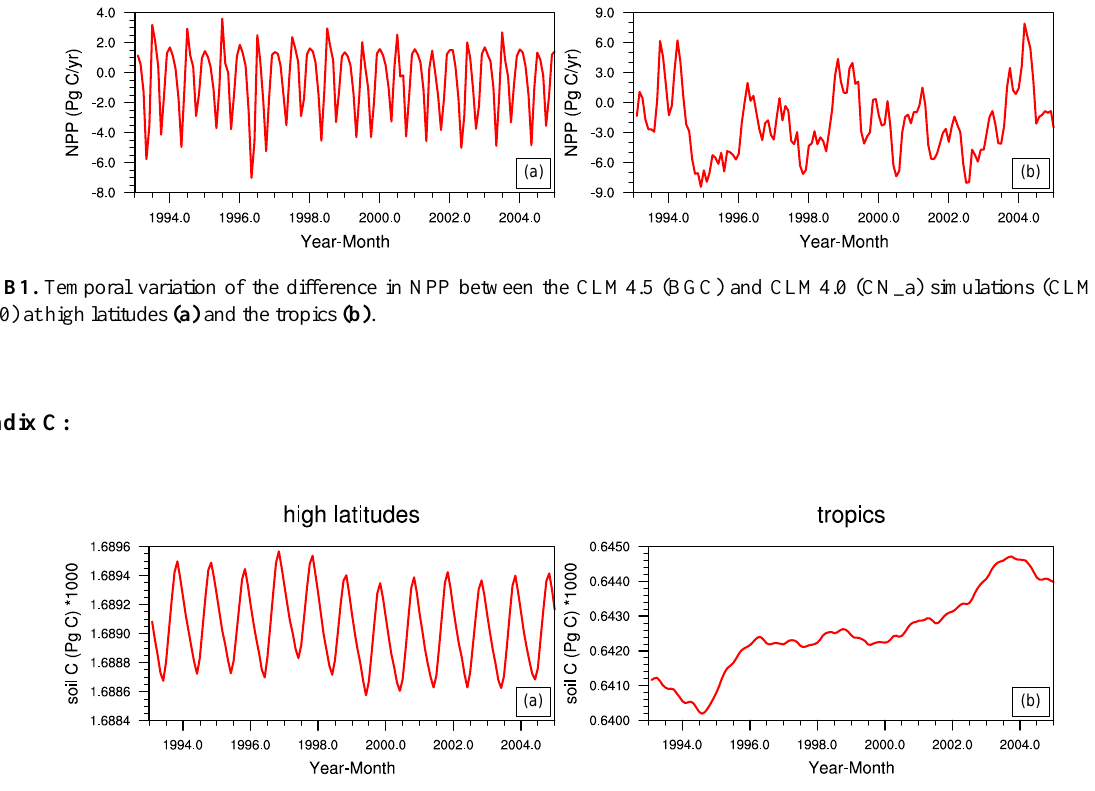
Figure C1. Temporal variation of the difference in soil C between the CLM4.5 (BGC) and CLM4.0 (CN_a) simulations (CLM4.5 minus CLM4.0) at high latitudes (a) and the tropics (b) . Please note that the CN_a model produced substantially less soil C than the BGC